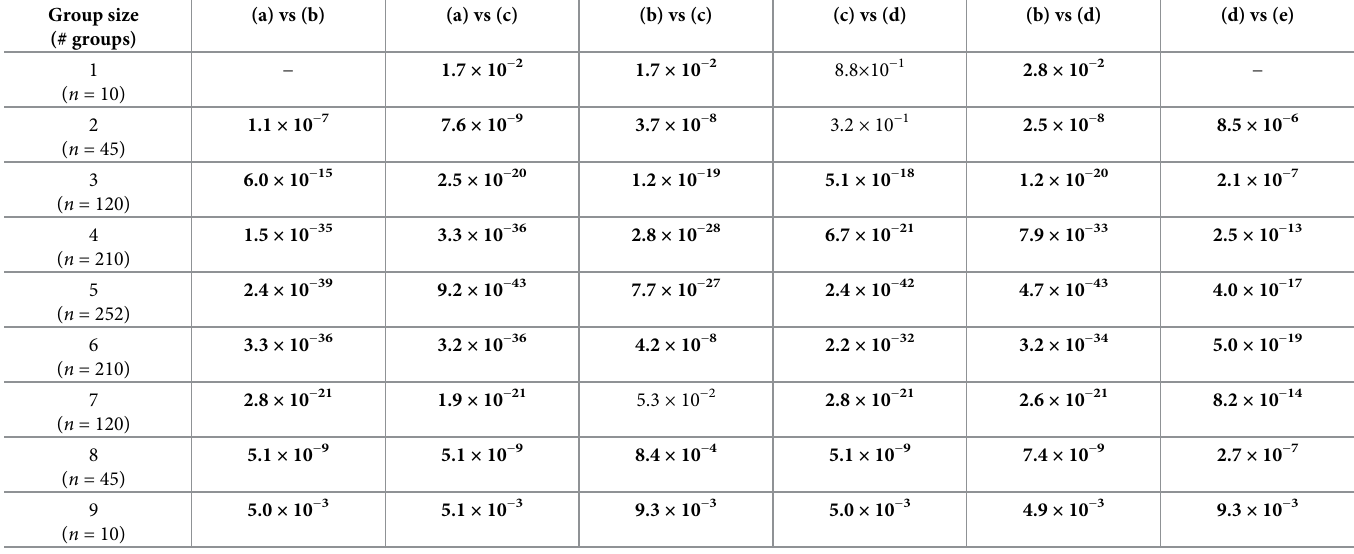
Table 1. Two-sided p -values of the Wilcoxon signed-rank test comparing the performance of: (a) traditional groups, (b) BCI-assisted groups, (c) ResNet-assisted groups, (d) BCI-and-ResNet-assisted groups, and (e) groups of BCI-and-ResNet-assisted humans. Values in bold represent p < 0.05 confidence level. Group size (#